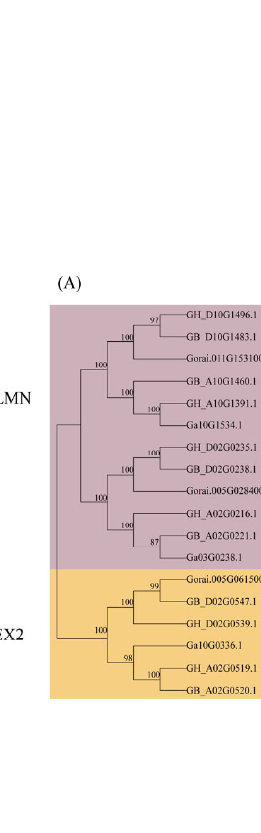
Figure 3. Analysis of Ka and KS ratio of three cotton species. The blue square stands for Gh ‐ Gr; the green square stands for Ga ‐ Gr.